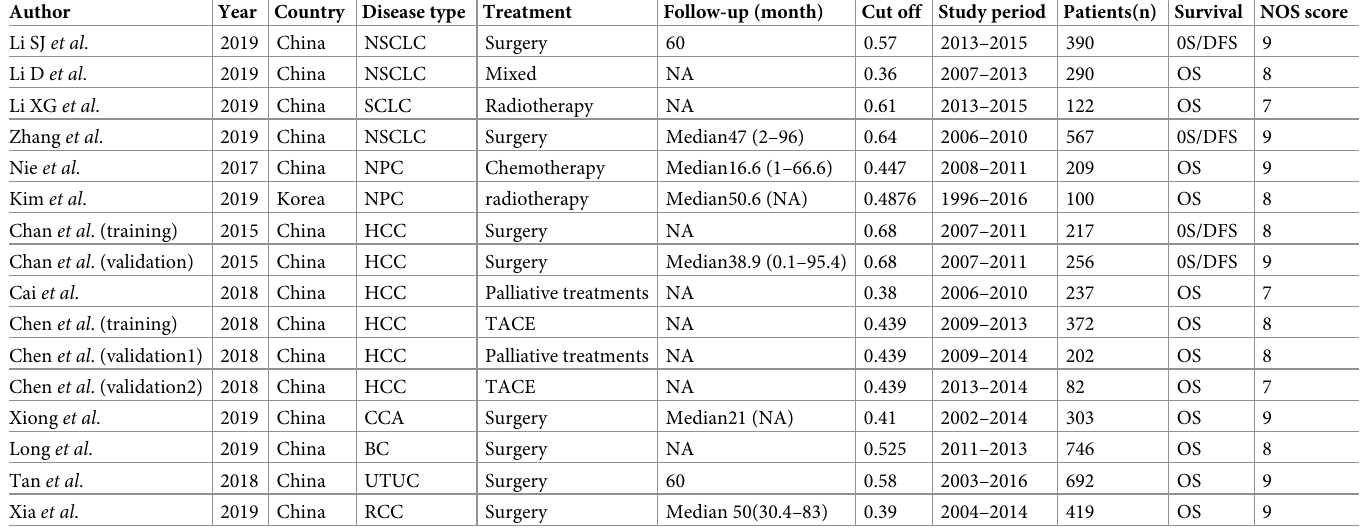
Table 1. The characteristics of the included